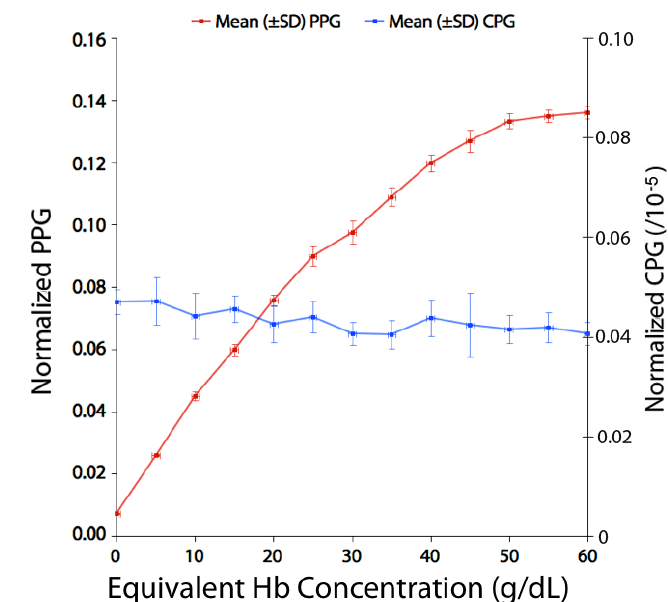
Figure 6. Graph of mean (±SD) normalized PPG amplitude (left y -axis) and mean (±SD) normalized CPG amplitude plotted against equivalent blood hemoglobin (Hb)